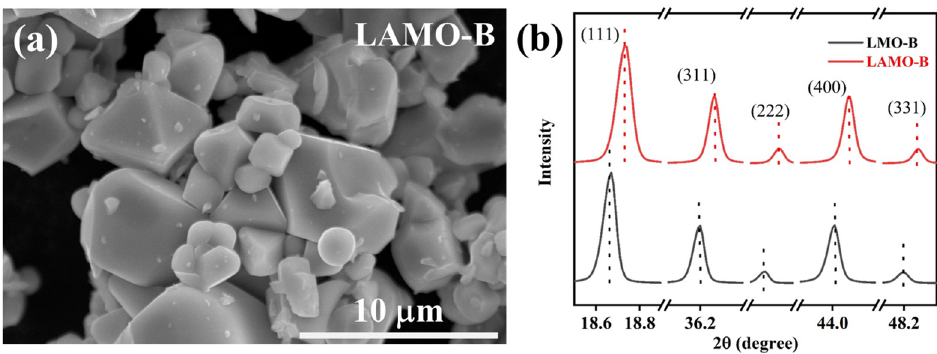
Figure 2. ( a ) Morphology of the LAMO-B sample. ( b ) The comparison of diffraction peaks of LMO-B and LAMO-B samples.